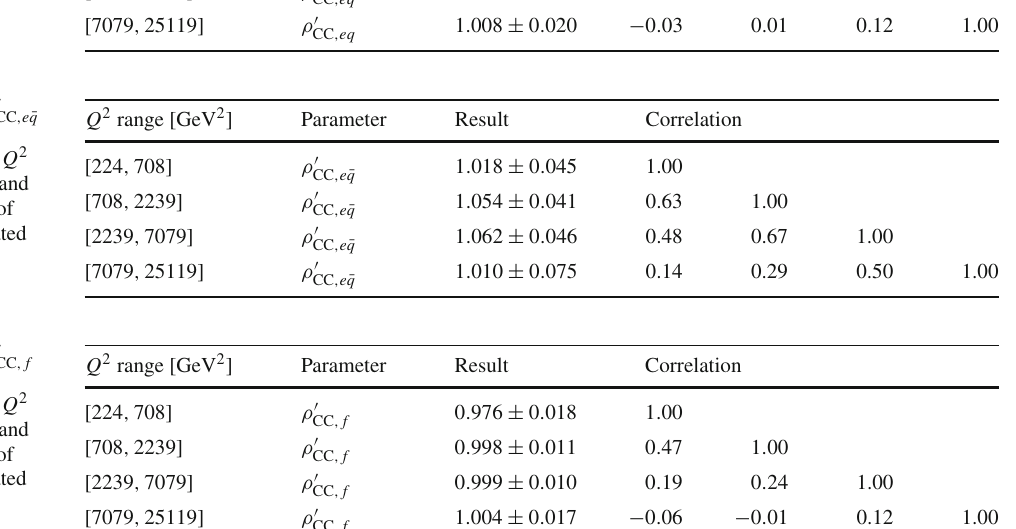
Table 16 Results for the ρ (cid:6) parameters determined at different values of Q 2 . The Q 2 range of the data selection, and the correlation coefficients of the fit parameters are indicated